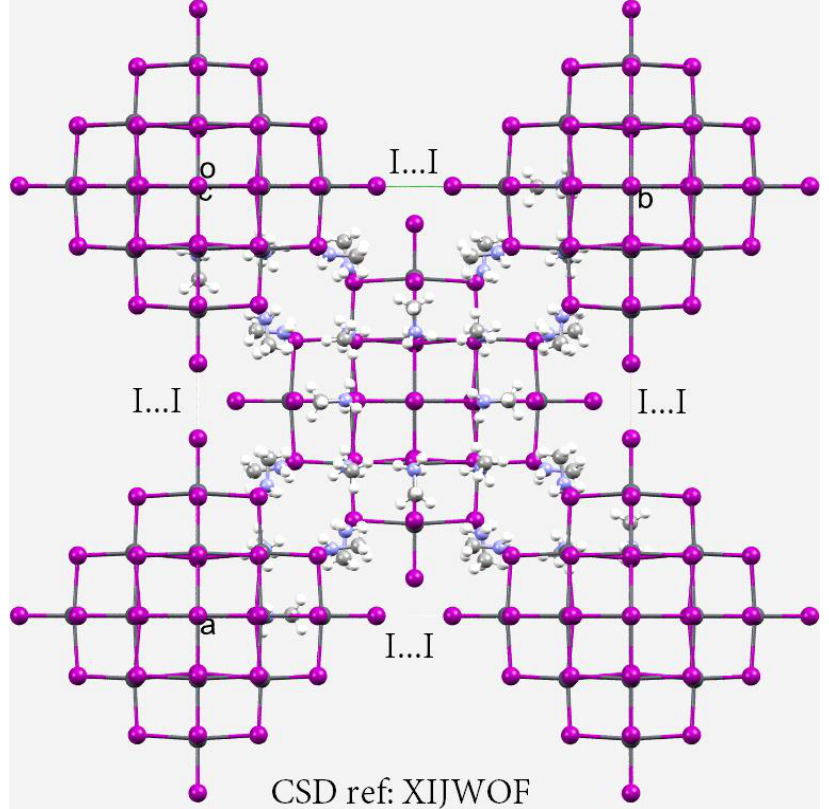
Figure 12. The ball-and-stick model of the unit-cell of the crystal structure of [I 44 Pb 18 ] 8 − [CH 3 NH 3 ] 8 Atoms are shown as balls and are color coded: Iodine — purple; Carbon — gray; N — blue; H — white. The CSD ref. code is shown.